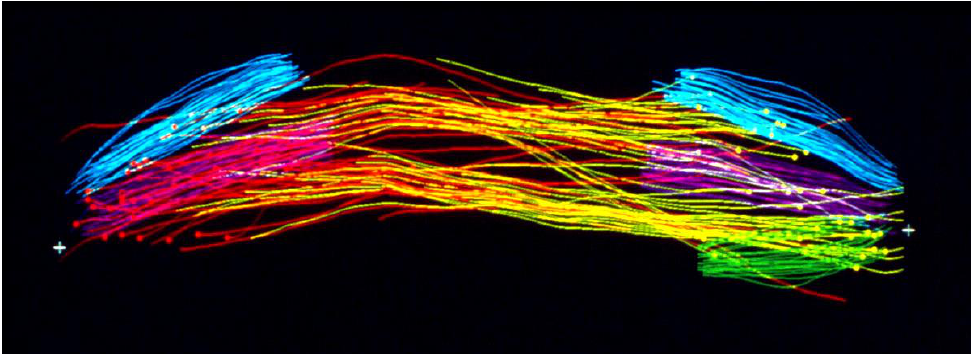
Figure 12. The paths of many spindle MTs, traced through serial sections of a mammalian cell (strain PtK2) in anaphase. White crosses mark the positions of the poindle poles. The shorter bundles of colored lines represent the kinetochore MTs that cluster to form the kinetochore fibers visible in the light microscope. (Colors are used simply to make these clusters stand out.) The red and yellow lines represent non-kinetochore MTs, which are associated with one pole or the other and interdigitate at the spindle’s midplane to make the “interpolar” spindle. These MTs slide and elongate during anaphase B. Image kindness of D. Mastronarde, Univ. Colorado.